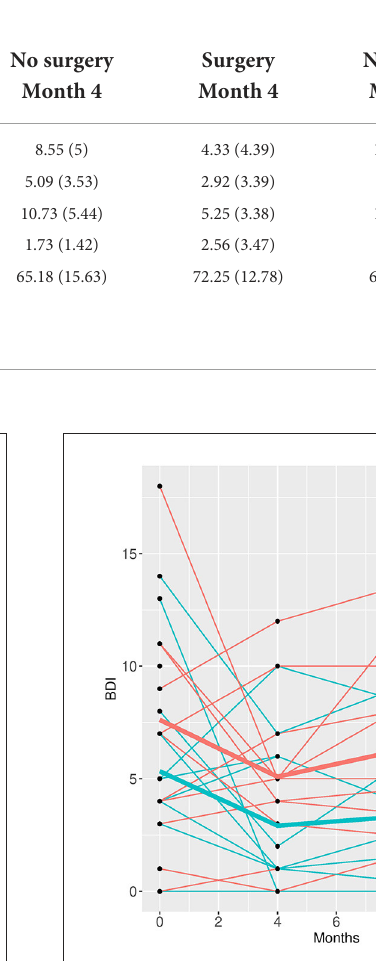
FIGURE1 HAM-D time course for individual patient data (thin lines) and averaged values (bold lines).